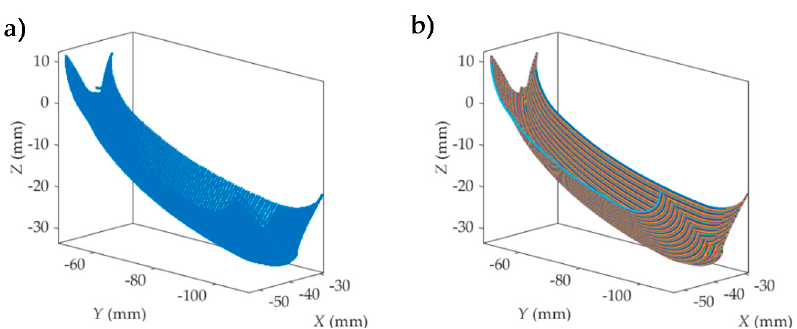
Figure 5. Interdental gap points ( a ) and trajectories ( b ) representation.